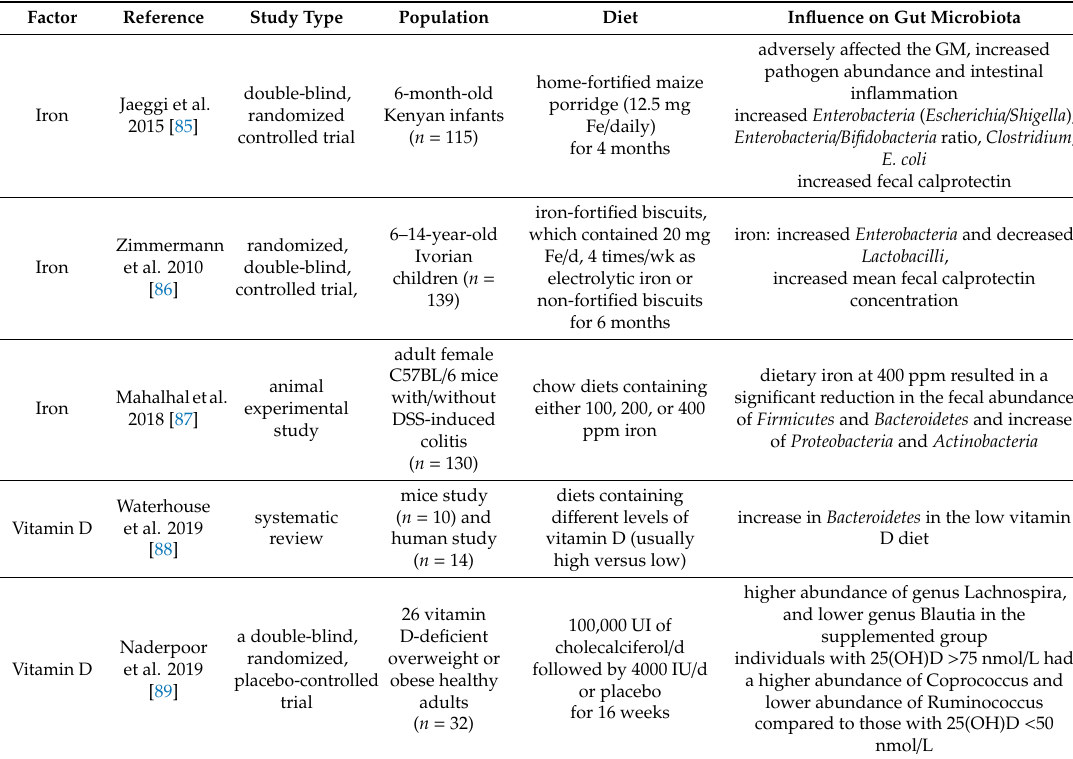
Table 4. Influence of selected dietary factors on